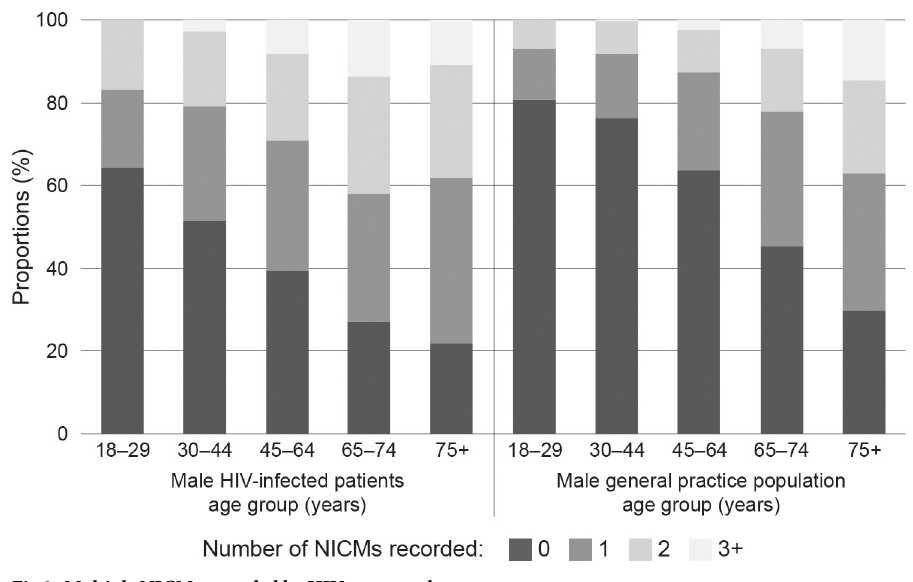
Fig 2. Multiple NICMs recorded by HIV status and age